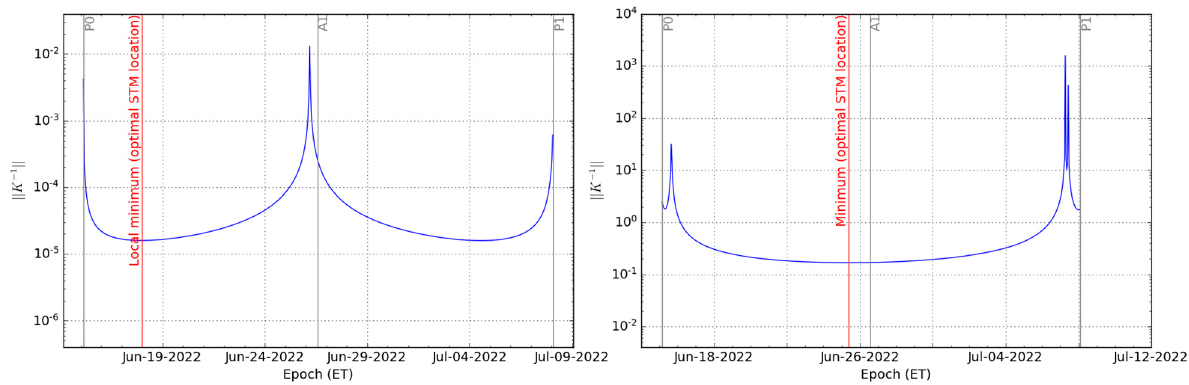
Figure 7. K-inverse norm evolution for the targeting of the cartesian position at the apogee A1 ( left ) and the cartesian velocity at the perigee P1 ( right ).